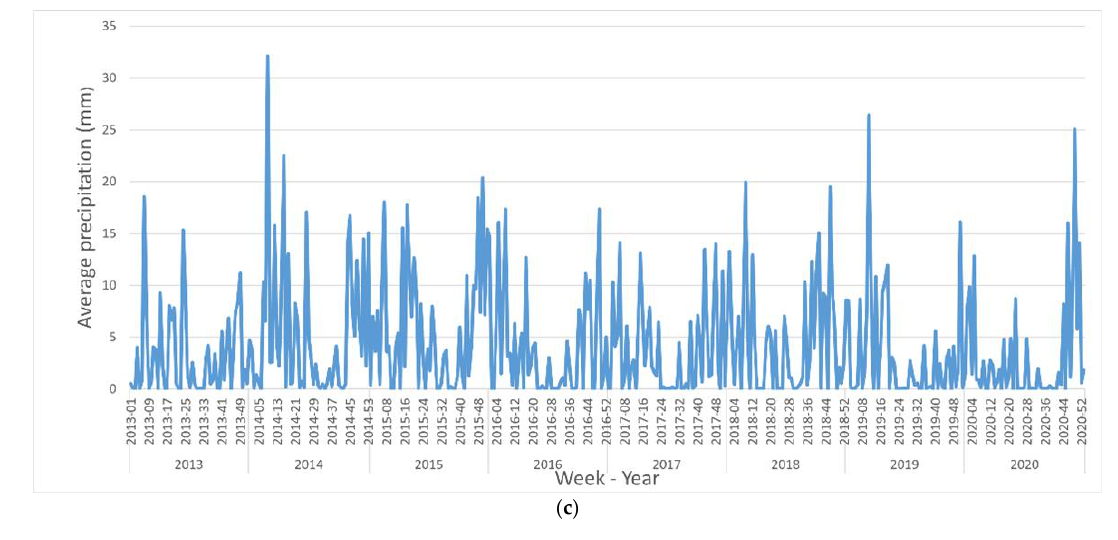
Figure 2. ( a ) Weekly average maximum temperature, ( b ) weekly average minimum temperature, and ( c ) average precipitation in Asuncion, Paraguay, 2013 – 2020. Table 2. Summary statistics of weekly climate factors from 2013 to 2020 in Asuncion, Paraguay.